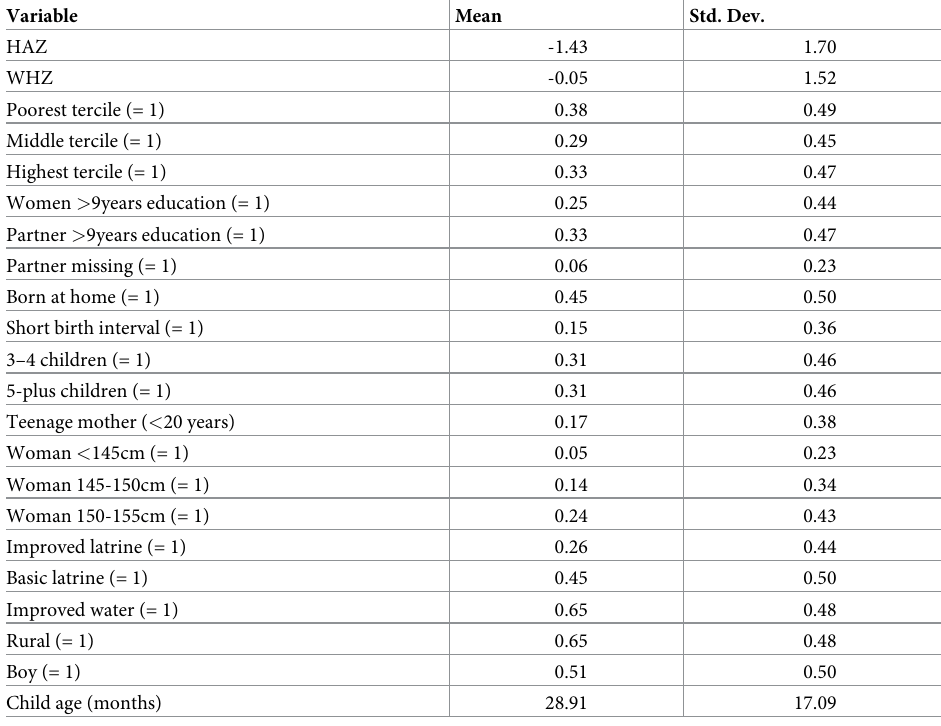
Source: Statistics derived from 125 Demographic Health Surveys from 57 countries. (N =